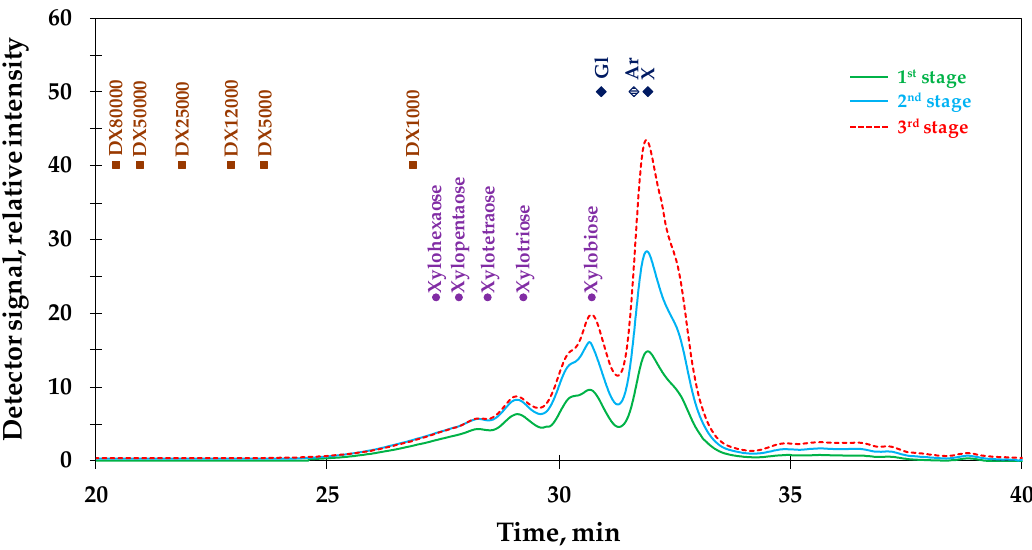
Figure 4. High Pressure Size Exclusion Chromatography (HPSEC) data obtained for the liquid phases from the 1st, 2nd and 3rd reaction stages, operating under conditions leading to the maximum concentration of XOs.